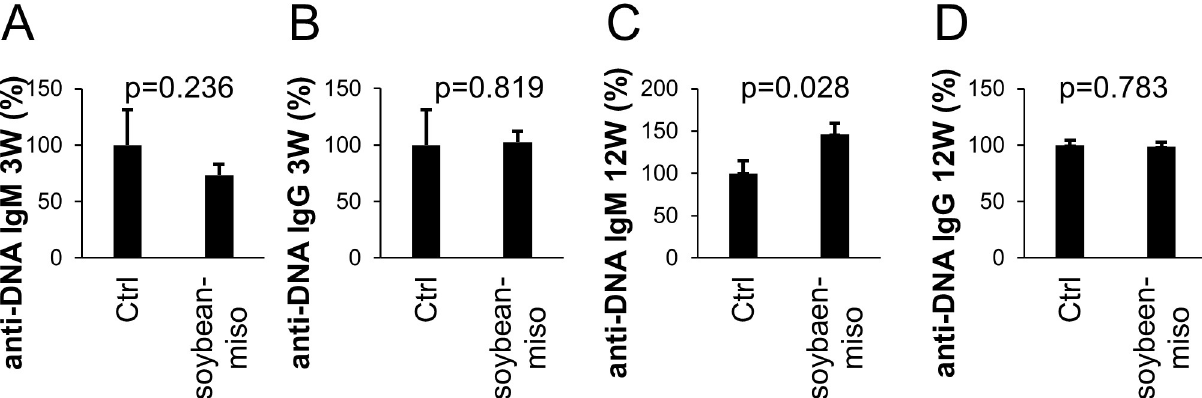
Fig 3. The effect of miso on Anti-DNA IgM and IgG production in serum. (A) Anti-DNA IgM levels in serum from mice fed for 3 weeks. (B) Anti- DNA IgG level in serum from mice fed for 3 weeks. (C) Anti-DNA IgM level in serum of mice fed for 12 weeks. (D) Anti-DNA IgG level in serum of mice fed for 12 weeks. Diet containing 5% soybean-miso was fed to C57BL/6 mice for 3 (n = 3) or 12 (n = 3) weeks. Then, spleen samples were collected and analyzed using flow cytometry. Bars indicate mean ± S.D. P-values relative to the control using a t-test.